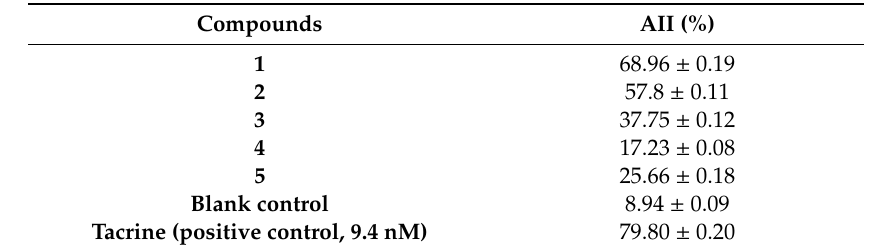
Table 2. The acetylcholinesterase (AChE) inhibit index (AII) of compounds 1 – 5 (94 nM) with the inhibition rate of this same